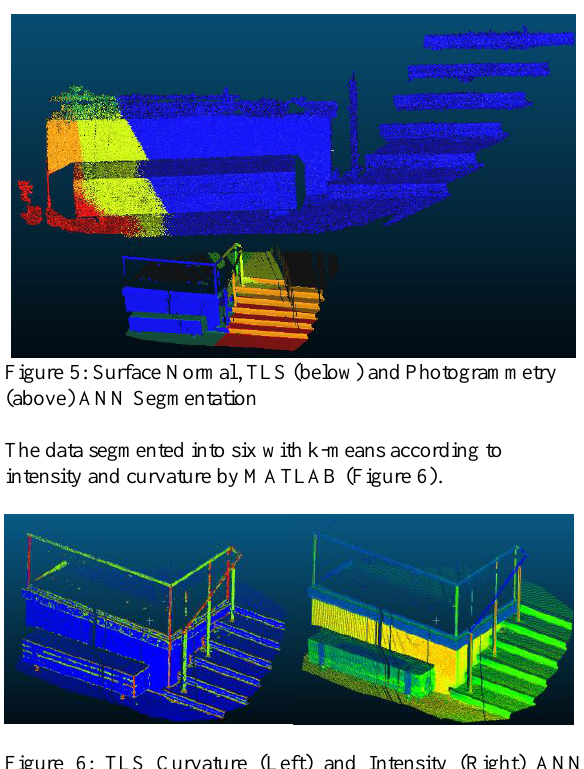
Figure 6: TLS Curvature (Left) and Intensity (Right) ANN